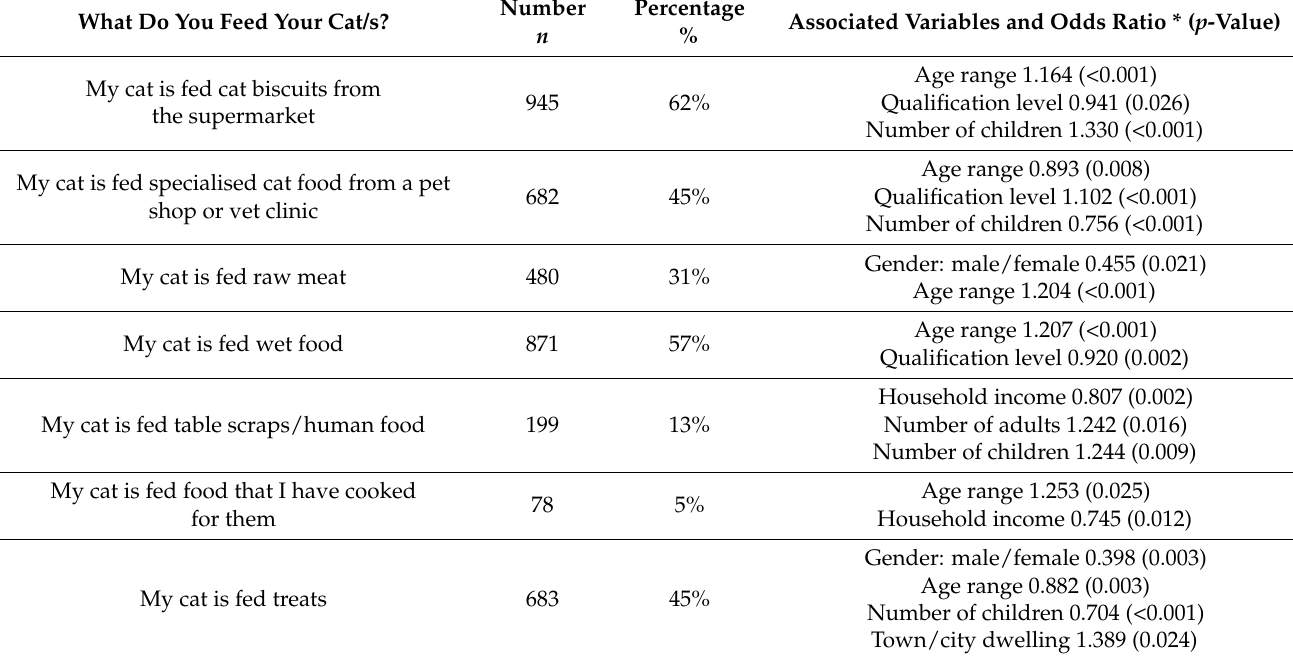
Table 1. Positive responses to the question “Which of these apply to your cat/s?” and factors and or variables that impact on the likelihood (odds ratio) of a positive